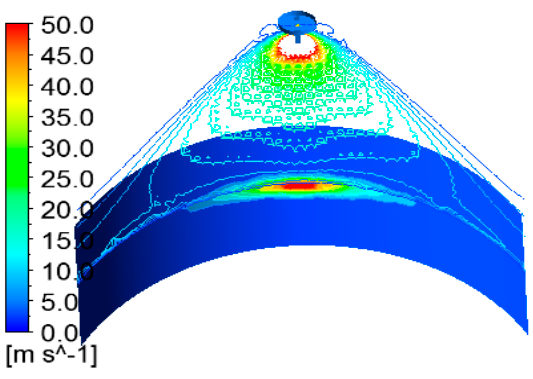
Figure 19. Cylindrical spraying: velocity contours in the plane X = 0 overlaid with static coating film thickness on the target.